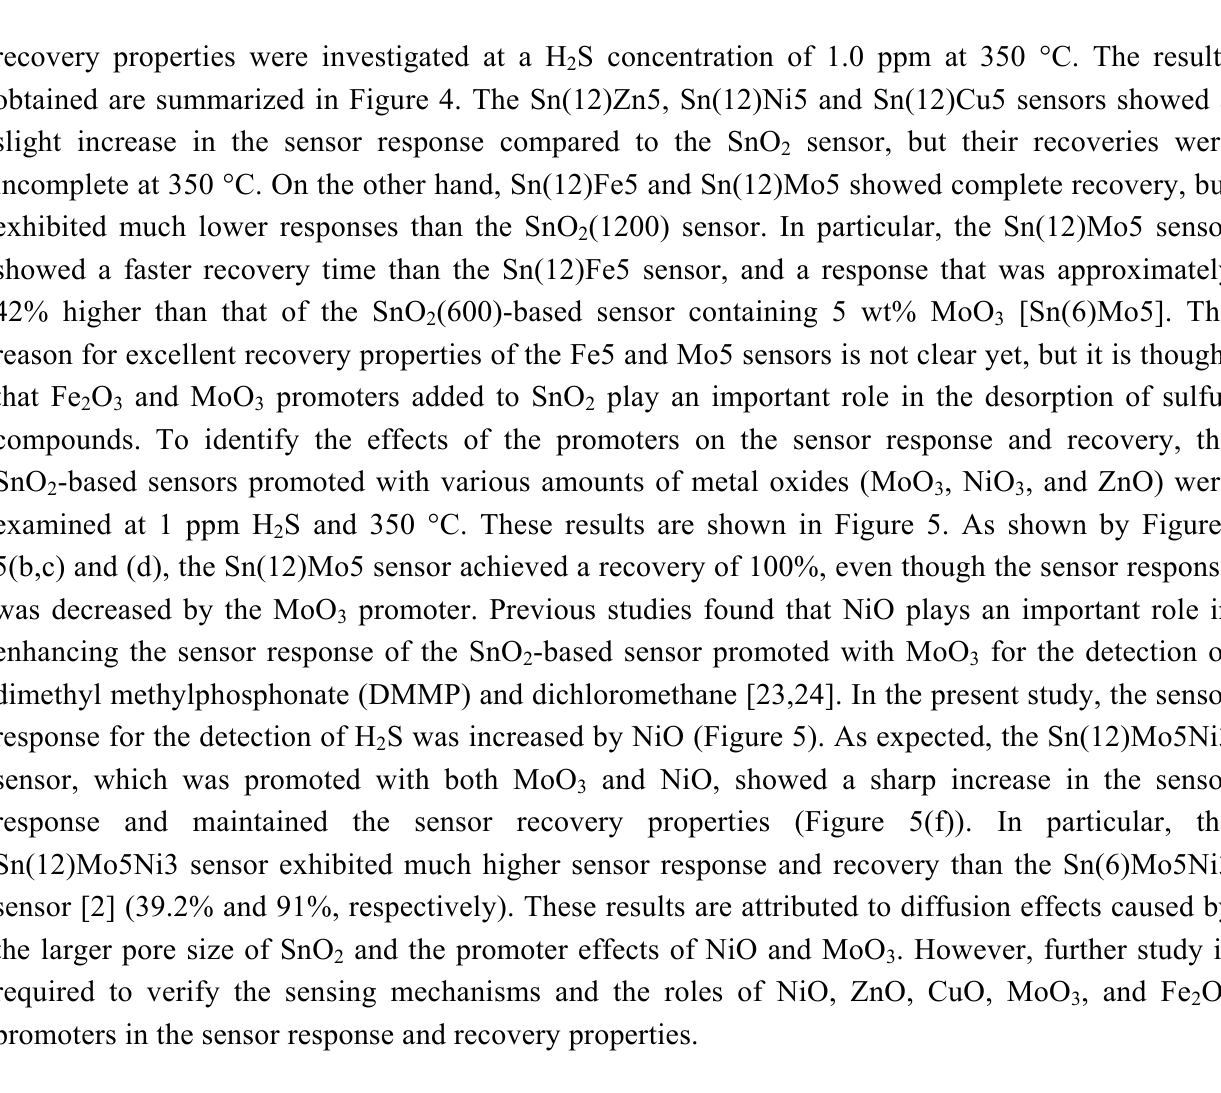
-based gas sensors promoted with various metal 2